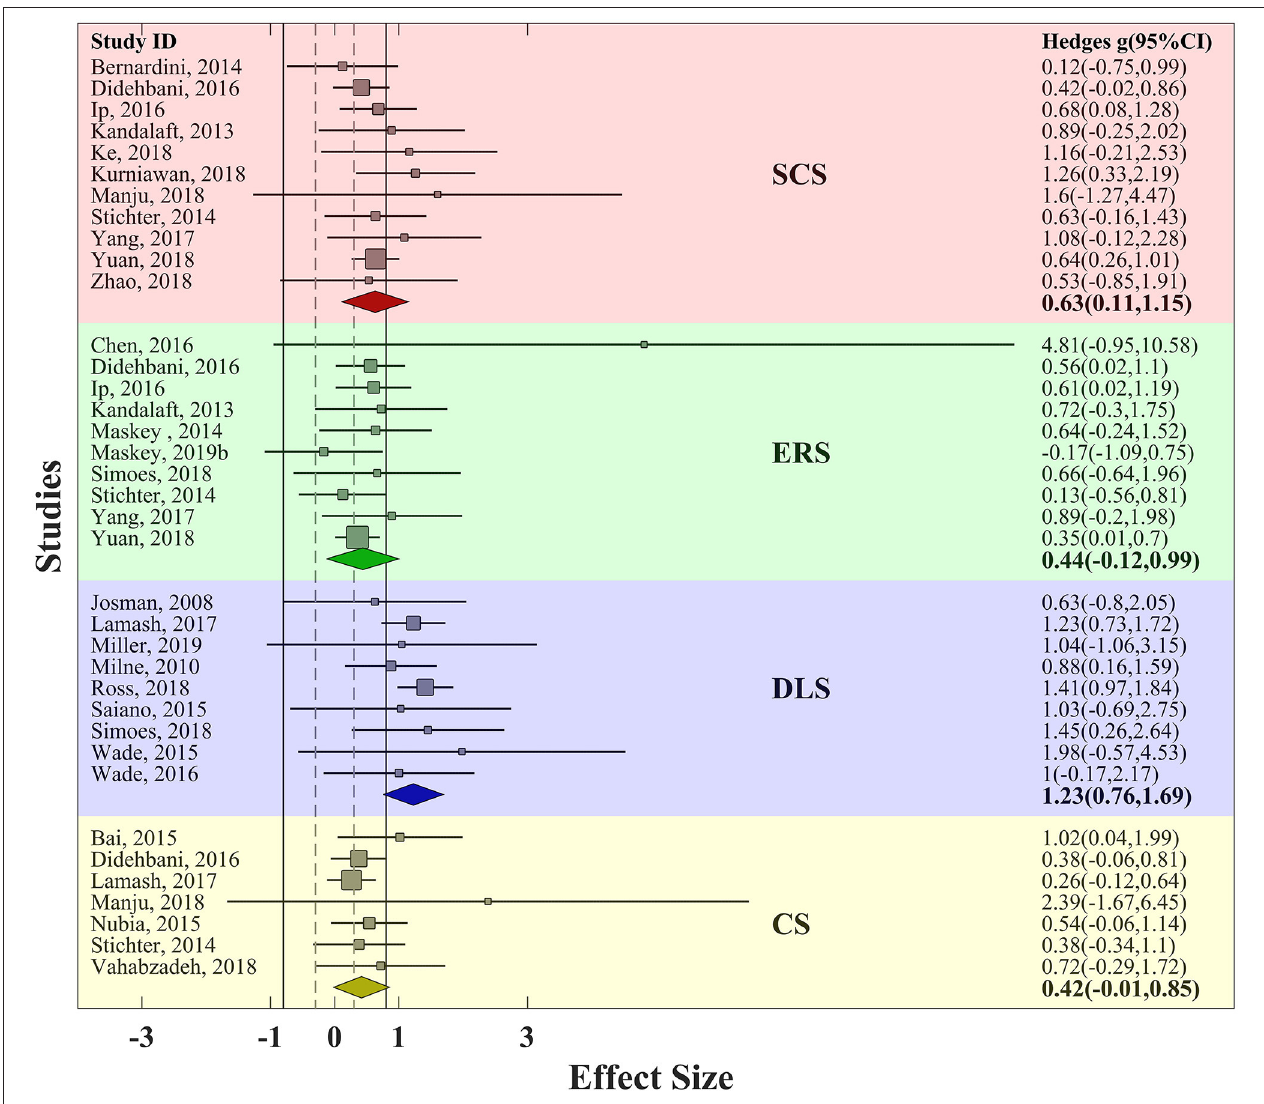
FIGURE 5 | Forest plot of skill-based training effectiveness for uncontrolled trials with 95% confidence interval. Red area represents SCS; green area represents ERS; blue area represents DLS; and yellow area represents CS. Solid vertical lines represent strong effect size boundary ( g represent weak effect size boundary ( g 0.3 and = −